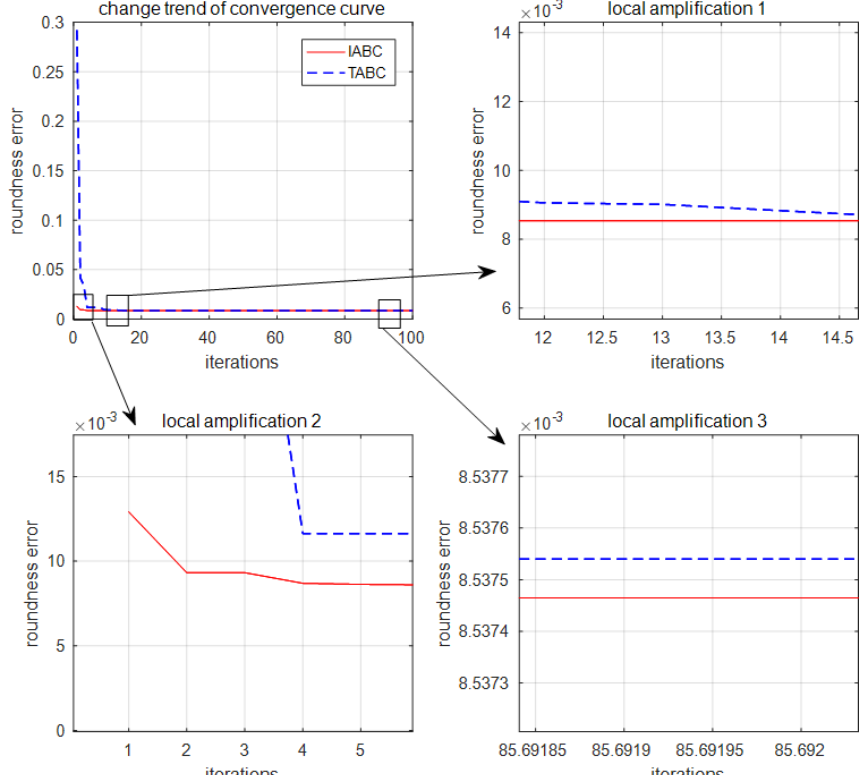
Figure 9. Convergence graph of iteration